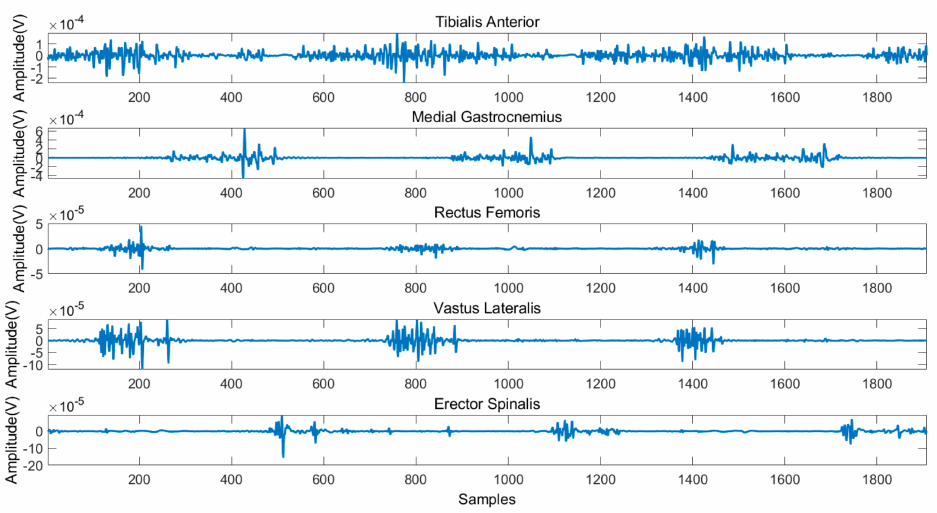
Figure 4. Typical sEMG signals during level ground